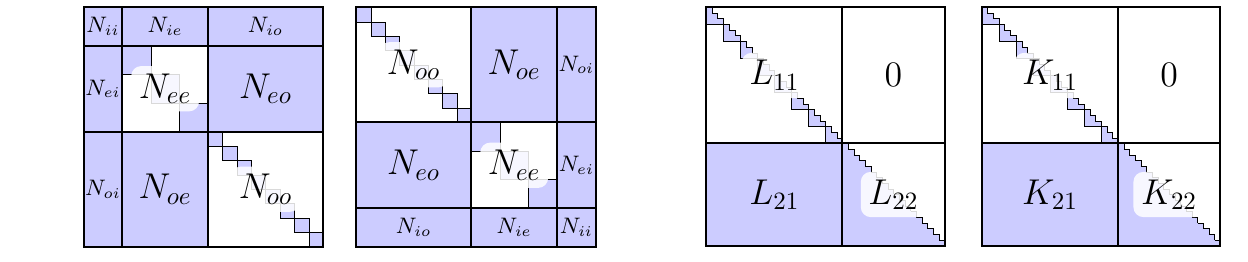
Figure 4: The non-zero patterns of the Cholesky factor L (left) forms half an arrowhead. The L 11 block is block diagonal with 3-by-3 lower triangular blocks. Due to the arrowhead shape of the normal matrix, the fill-in during the Cholesky factorisation is restricted to the lower triangular L 22 block. The L 21 block does not experience any fill-in at all. The non-zero pattern